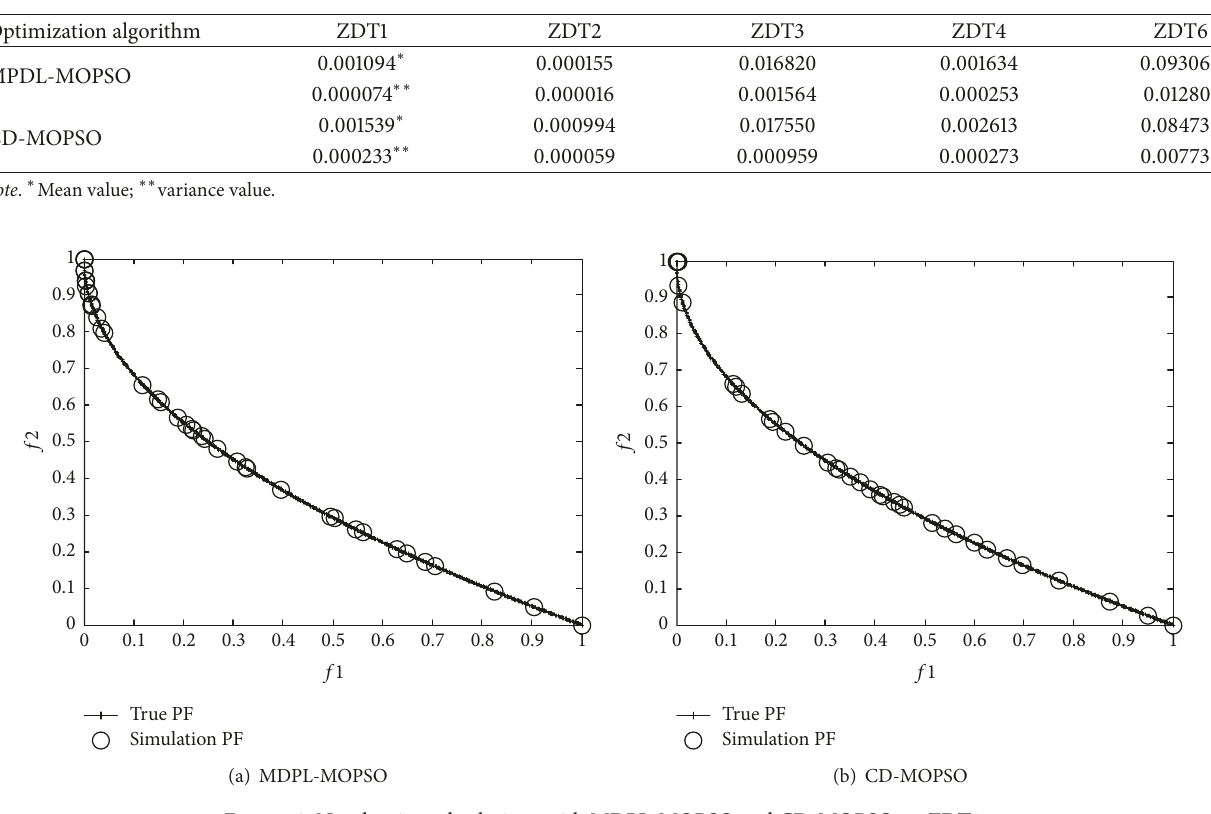
Table 3: 𝑆 results of optimal solutions for every problem.